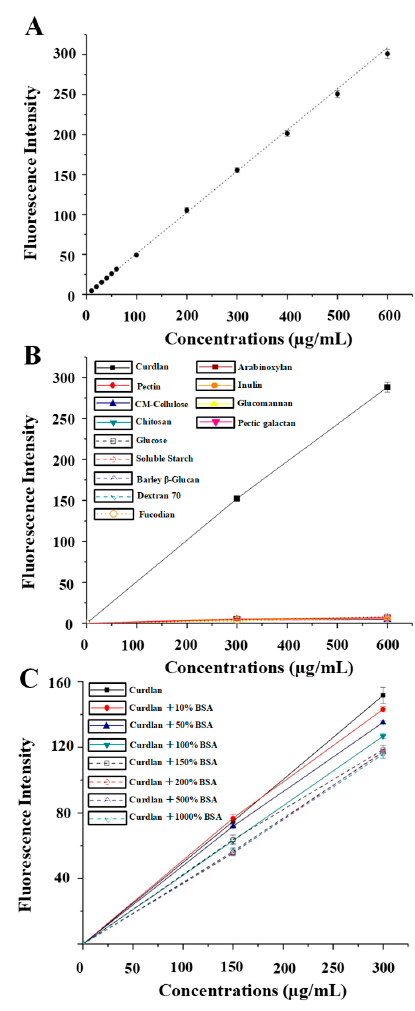
Figure 2. Calibration curve ( A ), specificity ( B ), and influence of protein on accuracy ( C ) of the improved fluorometric assay. All experiments were conducted in triplicate, and data are expressed in means ± standard deviations. The error bars are standard